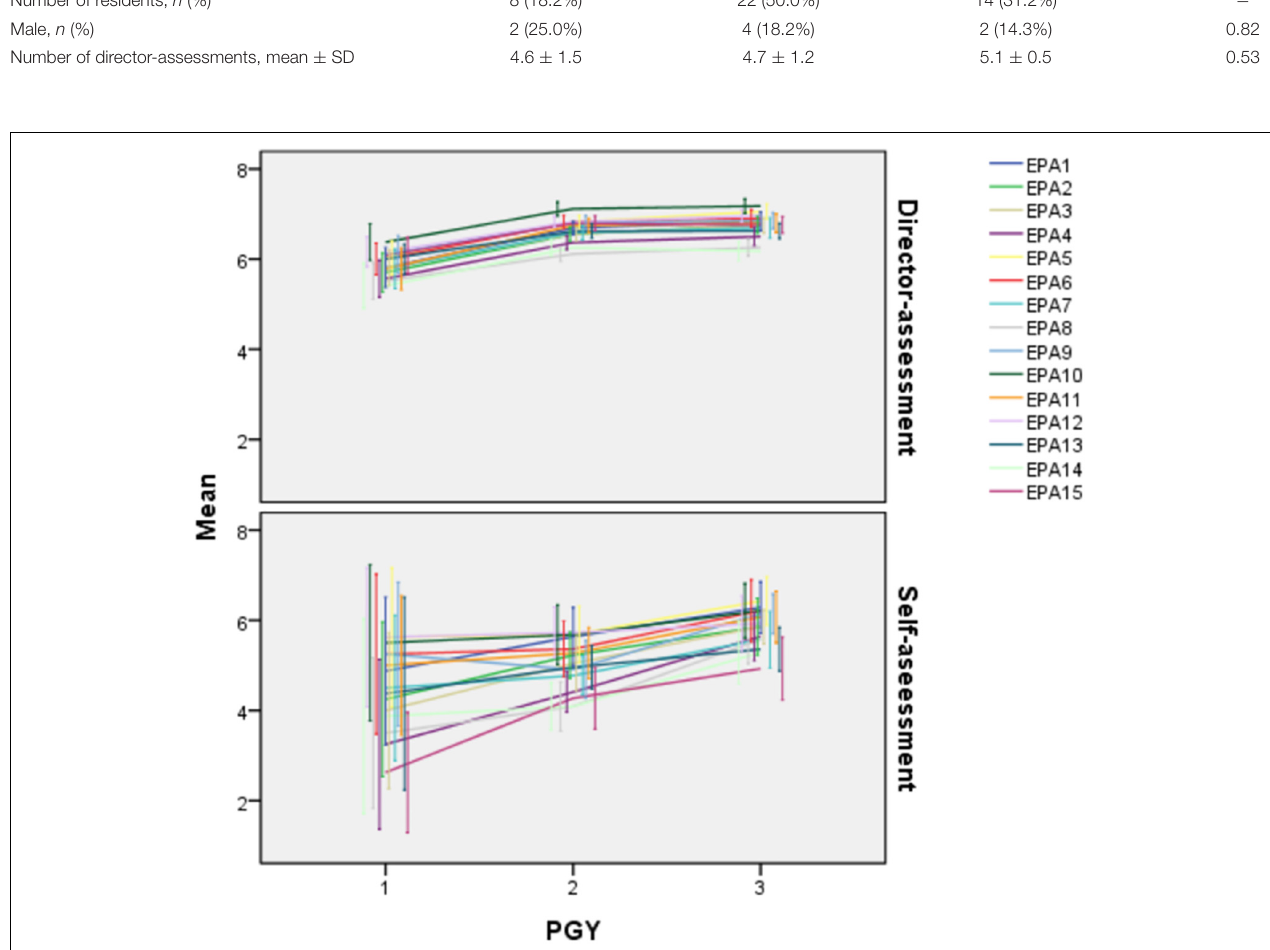
FIGURE 1 | Line graph of scores of director-assessment and self-assessment in each entrustable professional activity (EPA). Each point stands for the mean of scores of a certain subgroup, with bars standing for the 95% CI of the mean of each subgroup.